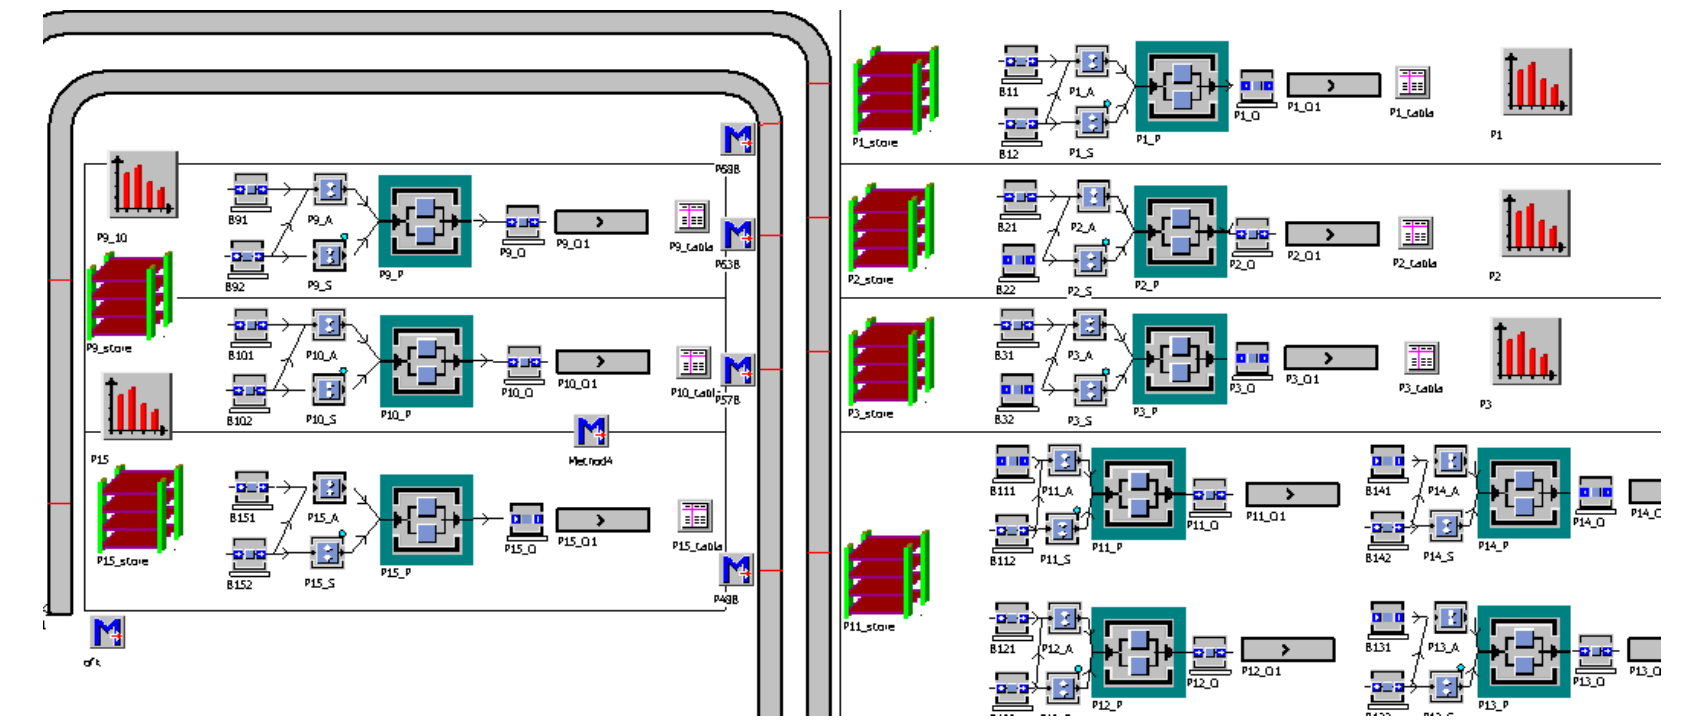
Figure 5. Simulation model of the examined materials handling system.